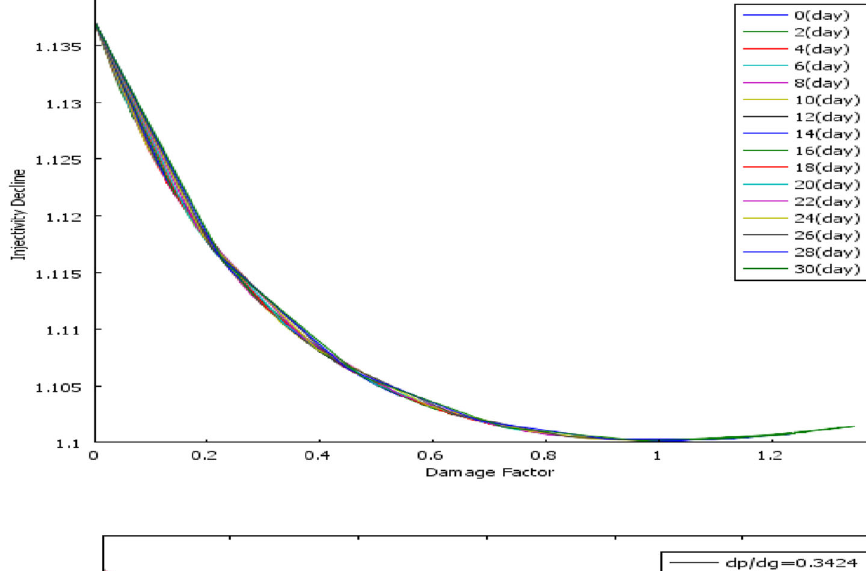
Fig. 24 Injectivity decline with time for different damage